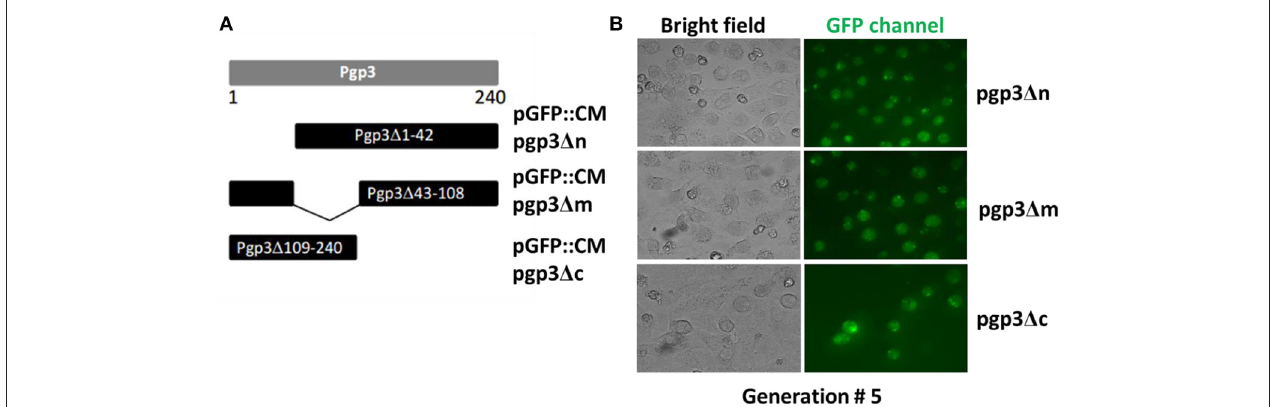
FIGURE 1 | Construction of Pgp3 domain deletion mutants. (A) The Pgp3 N-terminal (amino acids [aa] 1–42), middle (aa 43–108), or C-terminal (aa 109–240) domain was deleted from the full length plasmid GFP::CM to generate pGFP::CM pgp3 1 n, pGFP::CM pgp3 1 m, or pGFP::CM pgp3 1 c, respectively. (B) The plasmids harboring the Pgp3 domain deletions were transformed into a plasmid-free clone CMUT3 in the form of elementary bodies (EBs). The culture was incubated for 12h without ampicillin and then with ampicillin for another 20h. GFP-positive inclusion body pick-up selection and passage were repeated for 5 generations. The GFP-positive organisms were enriched. So the stable transformants pgp3 1 n, pgp3 1 m, and pgp3 1 c were produced successfully.